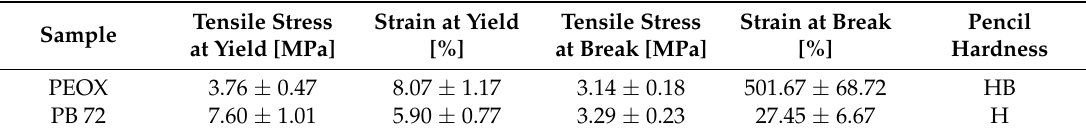
Table 2. The tensile strength of the film of PEOX and PB